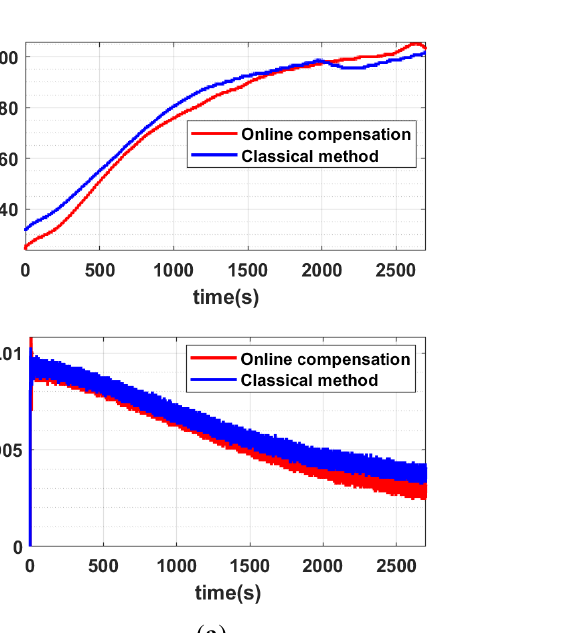
Figure 21. Comparison experiment block diagram based on classical formula MTPA.